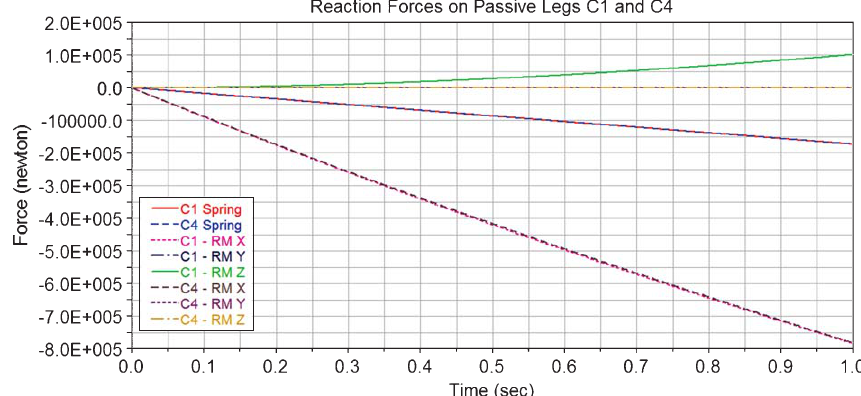
Fig. 17. Computed reaction forces in the Passive Legs C1 and